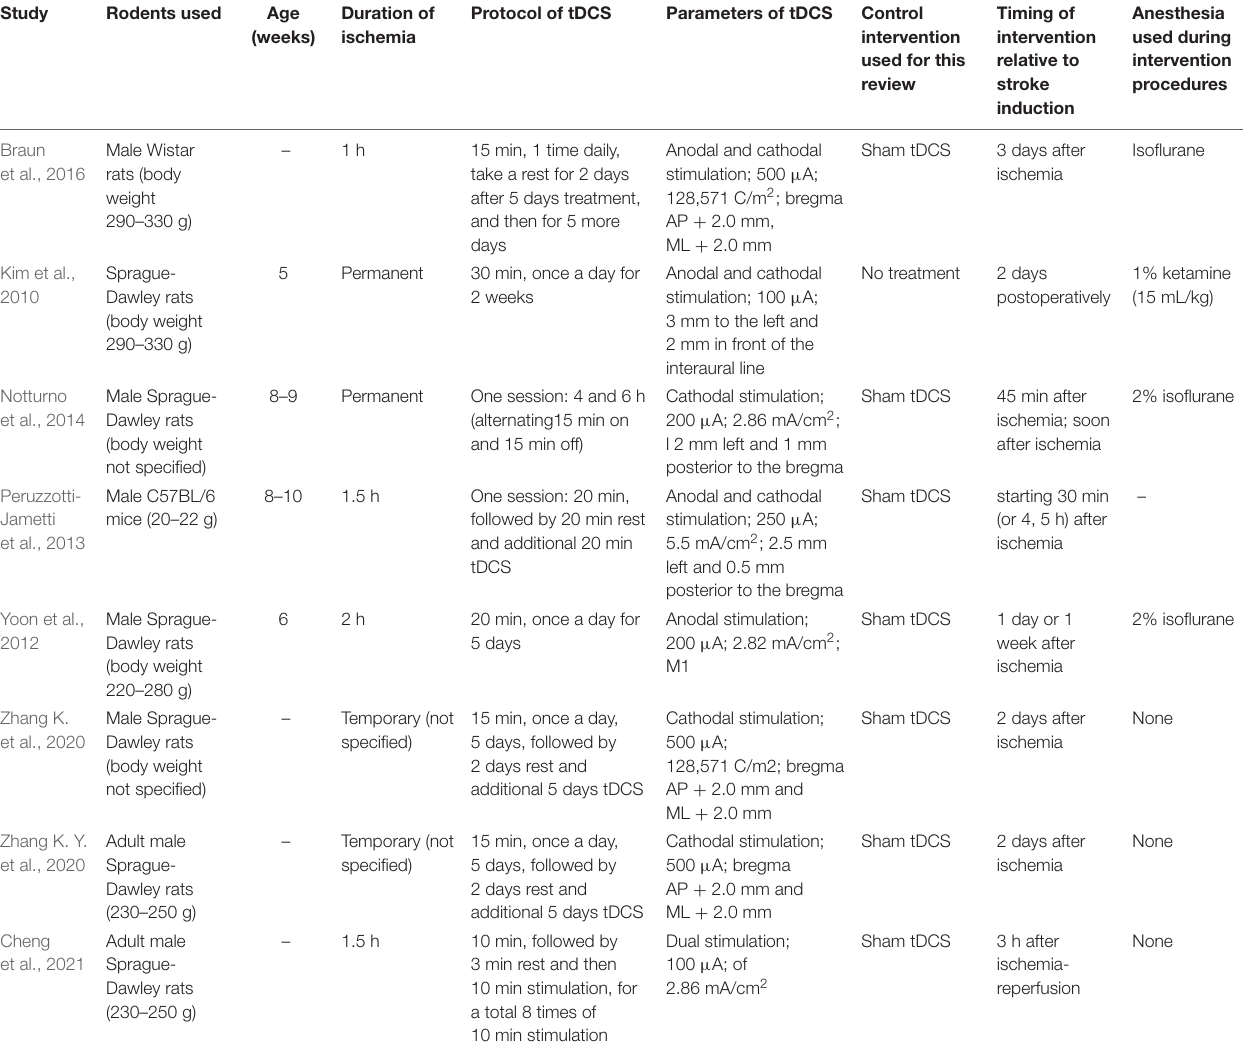
TABLE 1 | Characteristics of studies included in this meta-analysis, K =